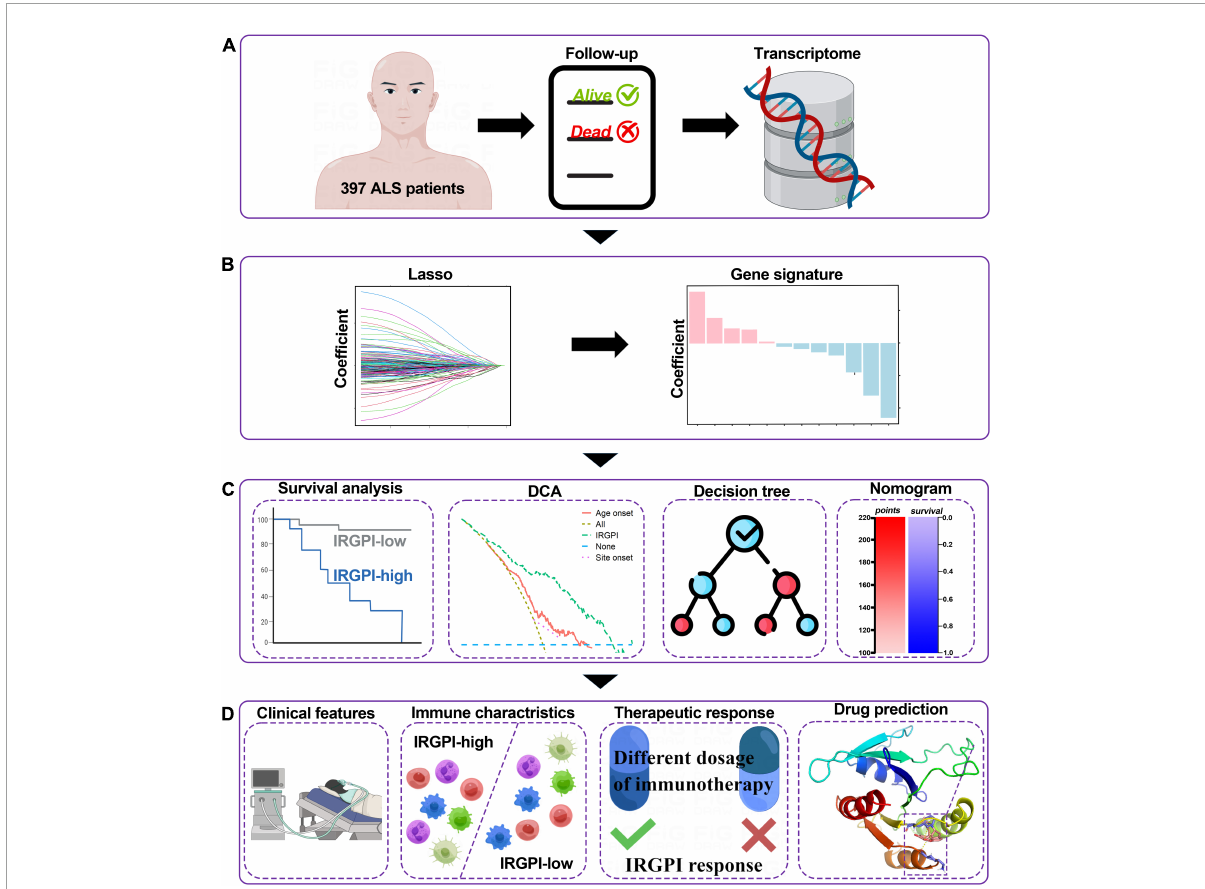
FIGURE1 Graphical abstract for the comprehensive study design, and the drawing was assisted by Figdraw (www.figdraw.com). (A) As a retrospective analysis of 397 patients with amyotrophic lateral sclerosis (ALS), this study evaluated the transcriptomic profiles and the clinical parameters. (B) Least absolute shrinkage and selection operator (LASSO) Cox algorithm was employed to construct immune gene signatures for prognosis. (C) Different cohorts and methods were used to validate the prognostic and predictive capabilities. (D) Comprehensive analyses of enriched pathways, immune landscape, therapeutic responses, and drug